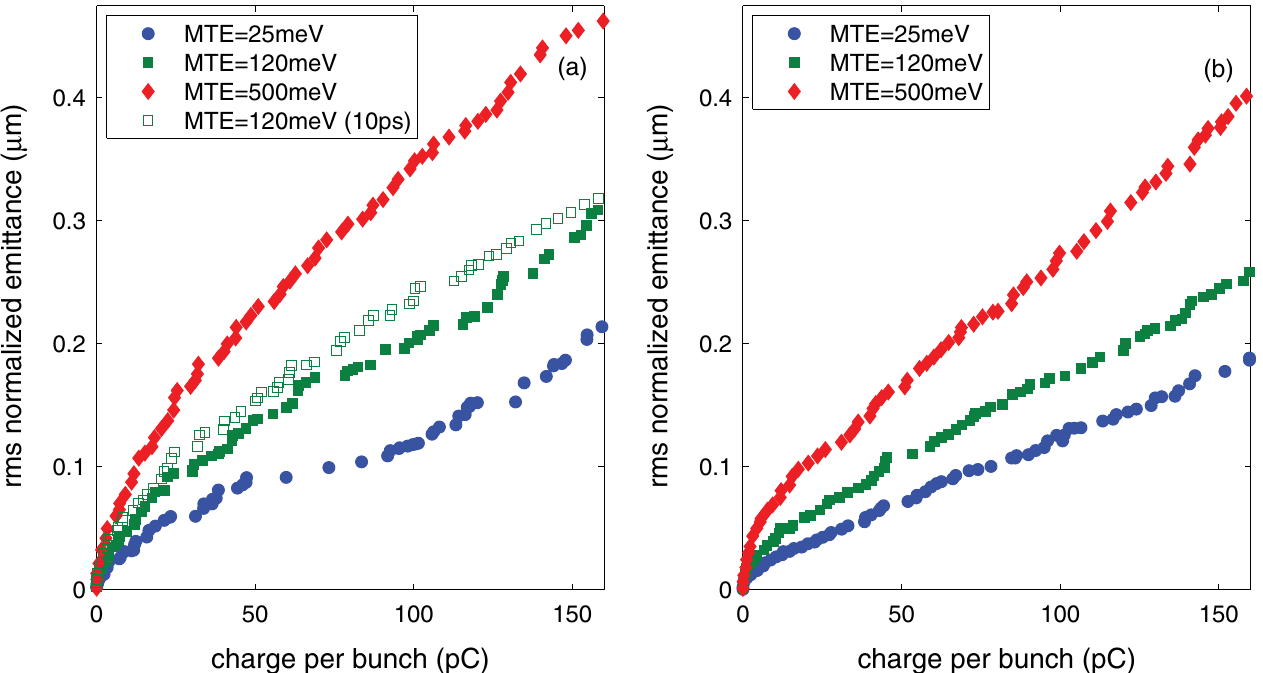
FIG. 7. Optimized emittance for various bunch charges for (a) dc gun and (b) SRF gun-based photoinjectors.